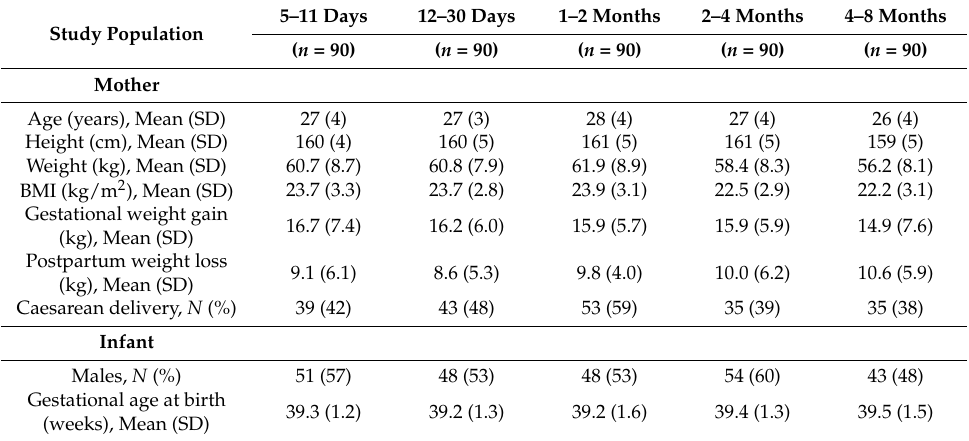
Table 1. Maternal and infant characteristics (adapted from [31]).